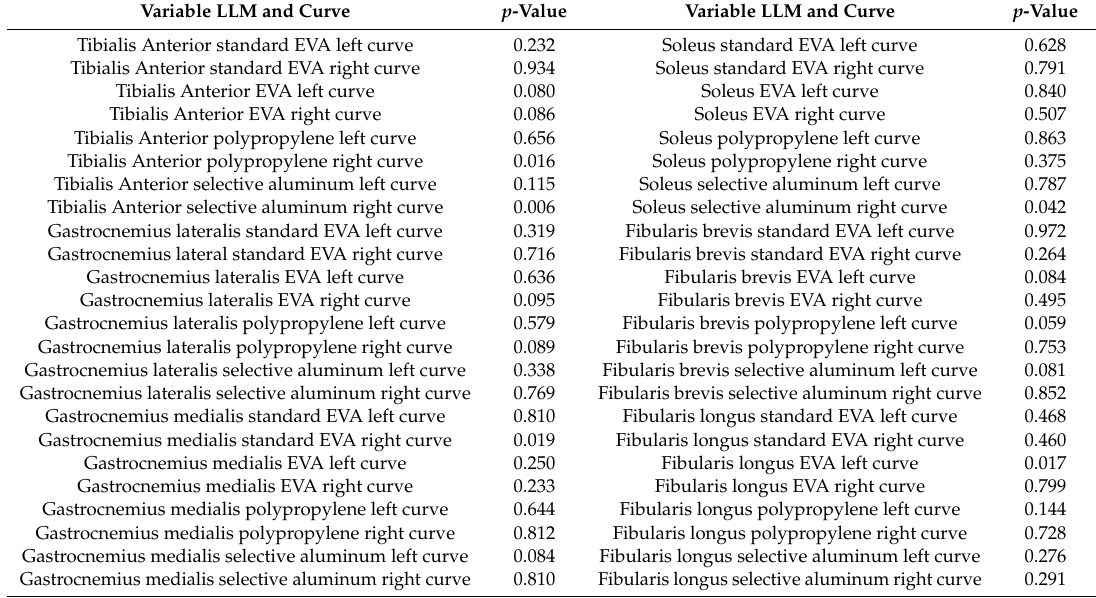
Abbreviations: EVA, ethylene vinyl acetate; Right curve, Knee touching the road; Left curve, Lower extremity towards the motorcycle body part. p Values are from Shapiro-Wilk tests Intraclass Correlation Coe ffi cient for EMG in